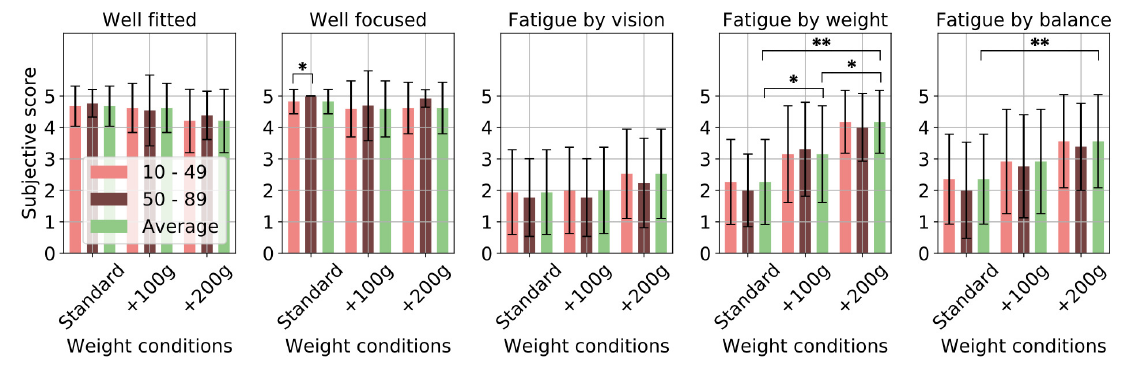
Figure 4. Questionnaire results for male participants in the “front” group. The results of Q1 to Q5 are shown from left to right. (*: p < 0.05, **: p < 0.01).